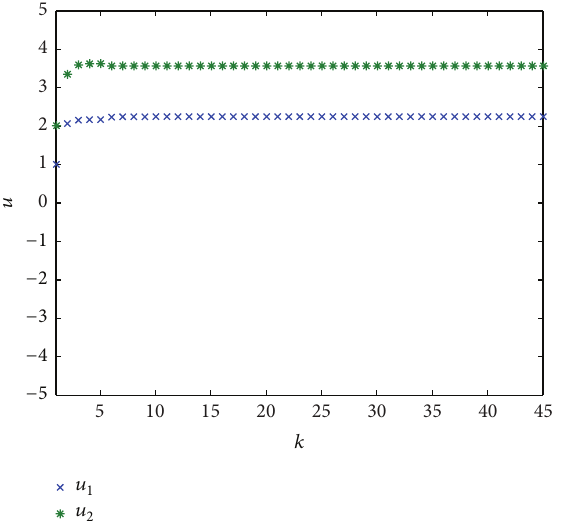
Figure 2: The trajectory of solutions of system (1) in Example